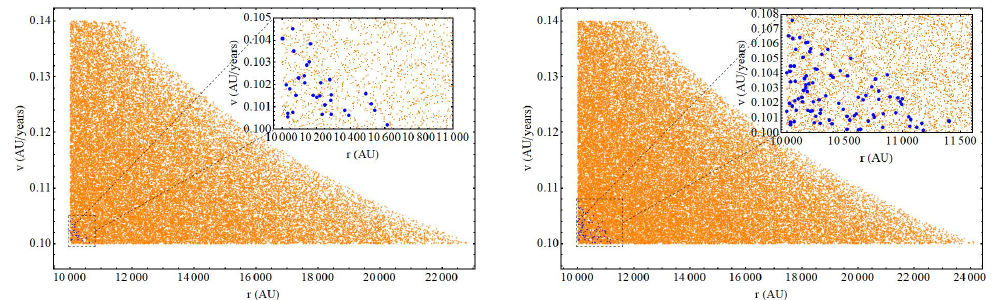
Figure 5. The velocity perturbation magnitude vs the initial position plots of the comets in the Monte Carlo simulations that are initially in stable orbits staying at perihelion distance larger than 10 AU. The orange points correspond to the comets whose elliptic trajectories remain outside the solar system despite the velocity perturbation, whereas the blue points correspond to those that enter our solar system after the same initial velocity perturbation. Left panel: The comet initial phase space coordinates before the gravitational transition. Right panel: The comet initial phase space coordinates after the gravitational transition has occurred, increasing the gravitational strength µ by 10%. Notice the significant increase in the number of comets that enter the solar